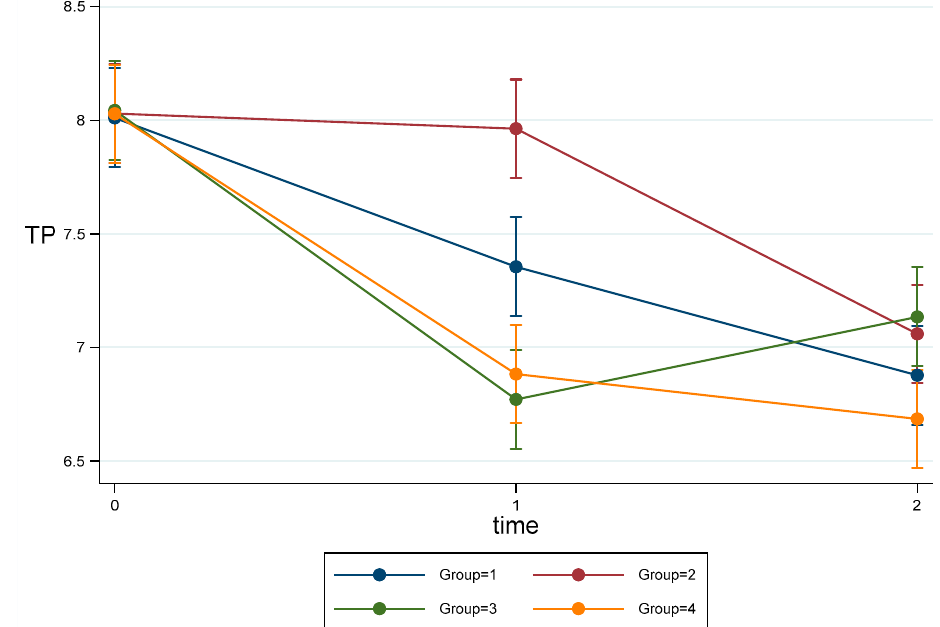
Figure 5. Estimated means and CI95% for TP Parameter adjusted for baseline values.